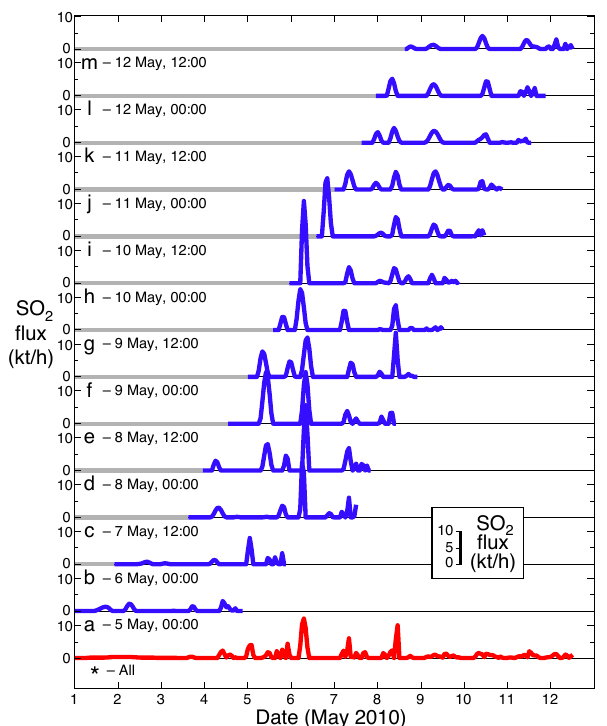
Fig. 4. Time series of the SO 2 flux released during the Eyjafjal- laj¨okull eruption (May 2010) reconstructed using ( a to m ) single- or ( ∗ ) multiple-image inversion. Each time series (from a to m ) corre- sponds to a SO 2 column amount map gathering IASI measurements acquired over a 12h time window, centred on the date indicated on the left. The multiple-image inversion scheme integrates all 13 IASI maps. SO 2 emissions released more than 3.5 days prior to the first acquisition time of the considered IASI image (grey lines) are not constrained by the inversion